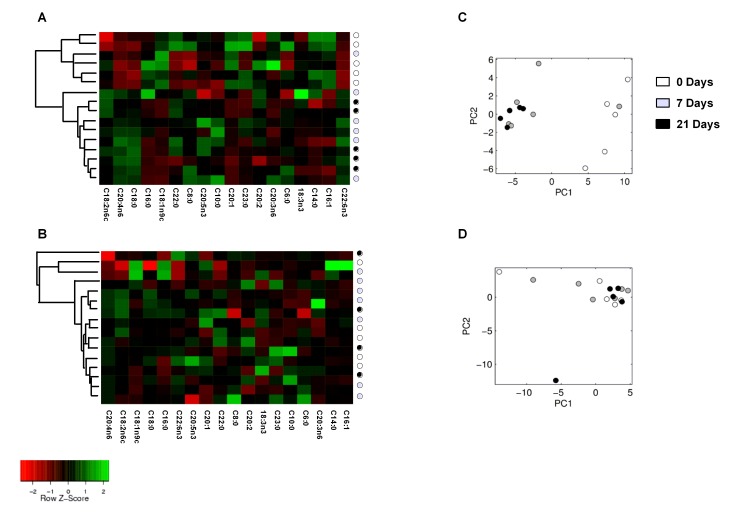
Heat maps and principal component analysis of fatty acid profiles.Heat maps and dendrograms visualizing the hierarchical clustering results (average linkage, Euclidean distance metric) of Meishan (A) and commercial piglets (B). Rows correspond to animals and the corresponding age group is indicated by coloured circles. The fatty acid mole percentiles were transformed to a z-score and indicated by a colour code, with red representing low percentiles and green high percentiles. Principal component analysis (PCA) plots of all Meishan (C) and all commercial piglets (D).